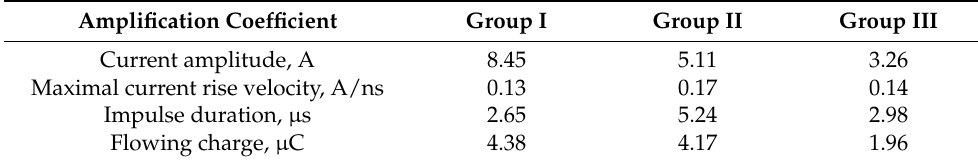
Table 1. Characteristics of the current impulse of streamer corona on the rod model elements (average values).